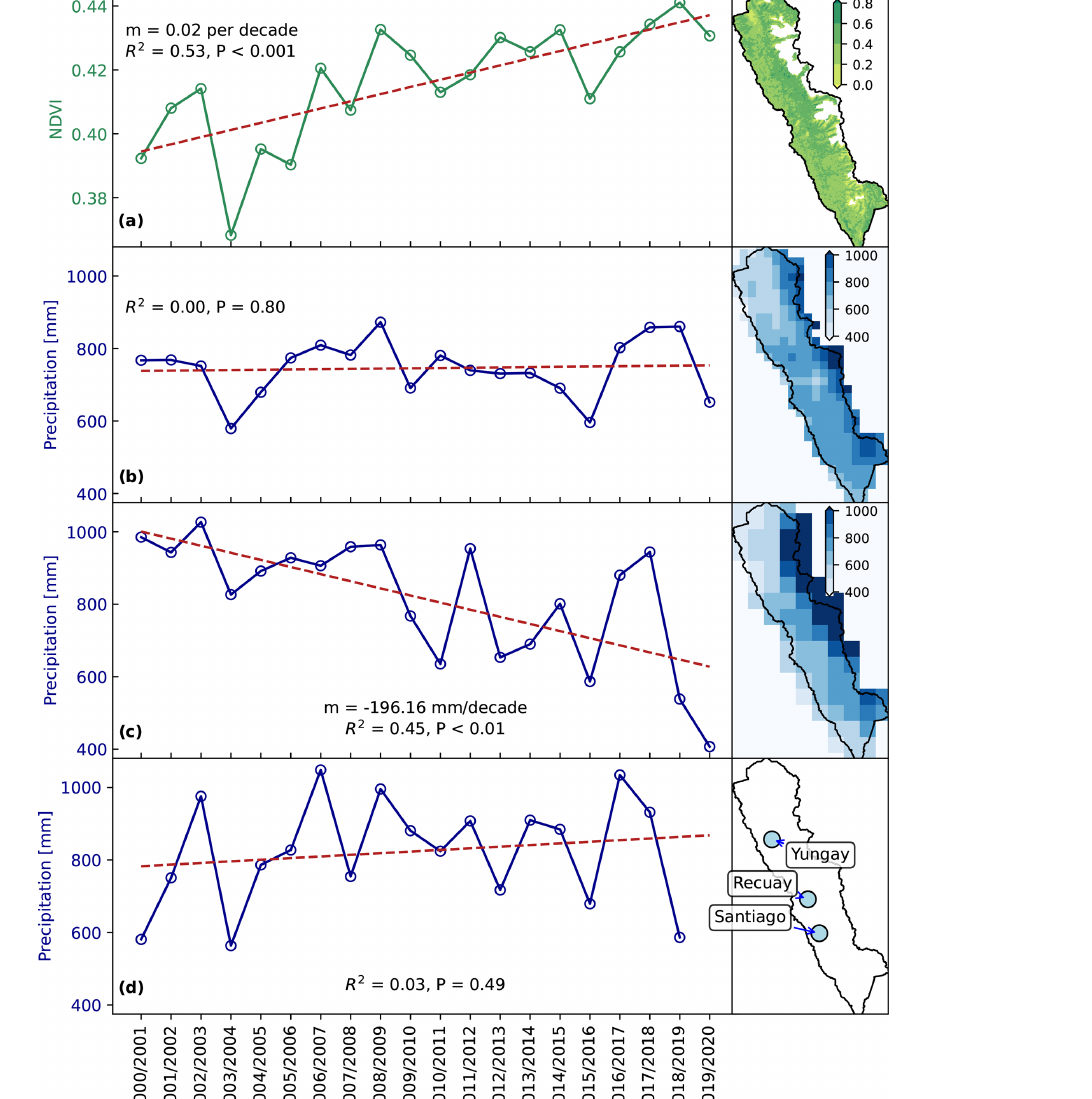
Figure 3. Seasonal domain mean time series and linear regressions for NDVI and three different rainfall products: (a) MODIS NDVI, (b) CHIRPS, (c) IMERG and (d) local weather station data (SENAHMI). Small maps show mean NDVI over the time series, mean annual precipitation sums and weather station